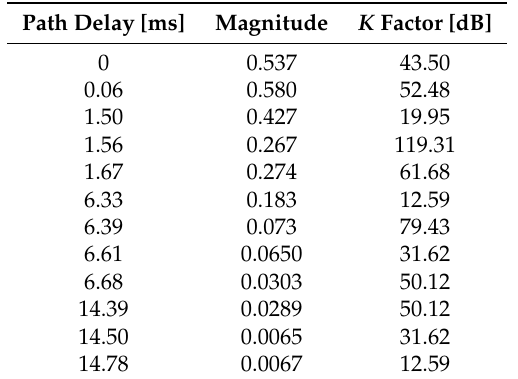
Table 1. Multipath channel generated by Bellhop channel model. Path Delay [ms]